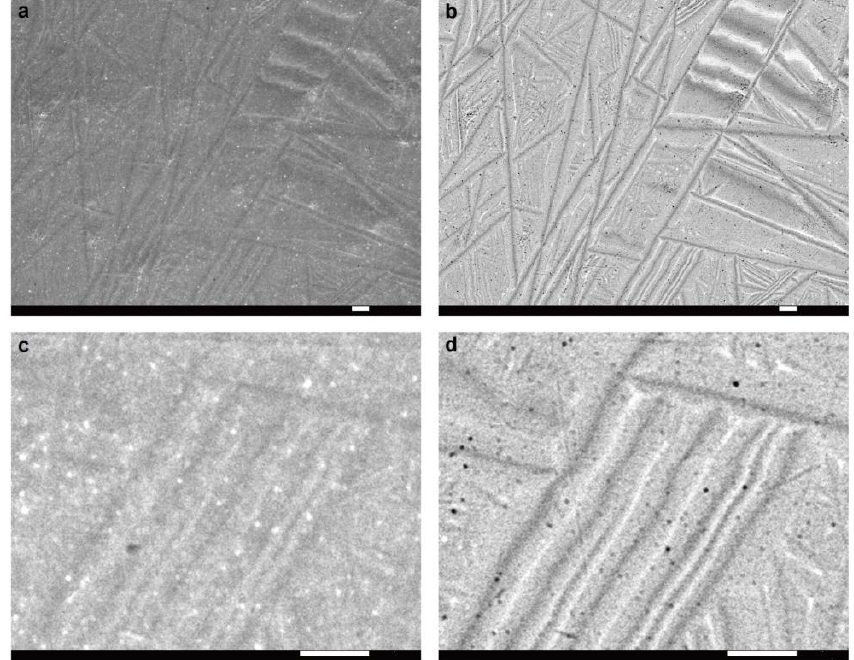
Figure 3. Cross-sectional ( a ) secondary-electron and ( b ) back-scattered-electron SEM images of the VAR-fabricated TiZr ingot before it was subjected to the mechanical forging. ( c , d ) Magnified images of areas in ( a ) and ( b ), respectively (magnification = 4×). All scale bars indicate a length of 10